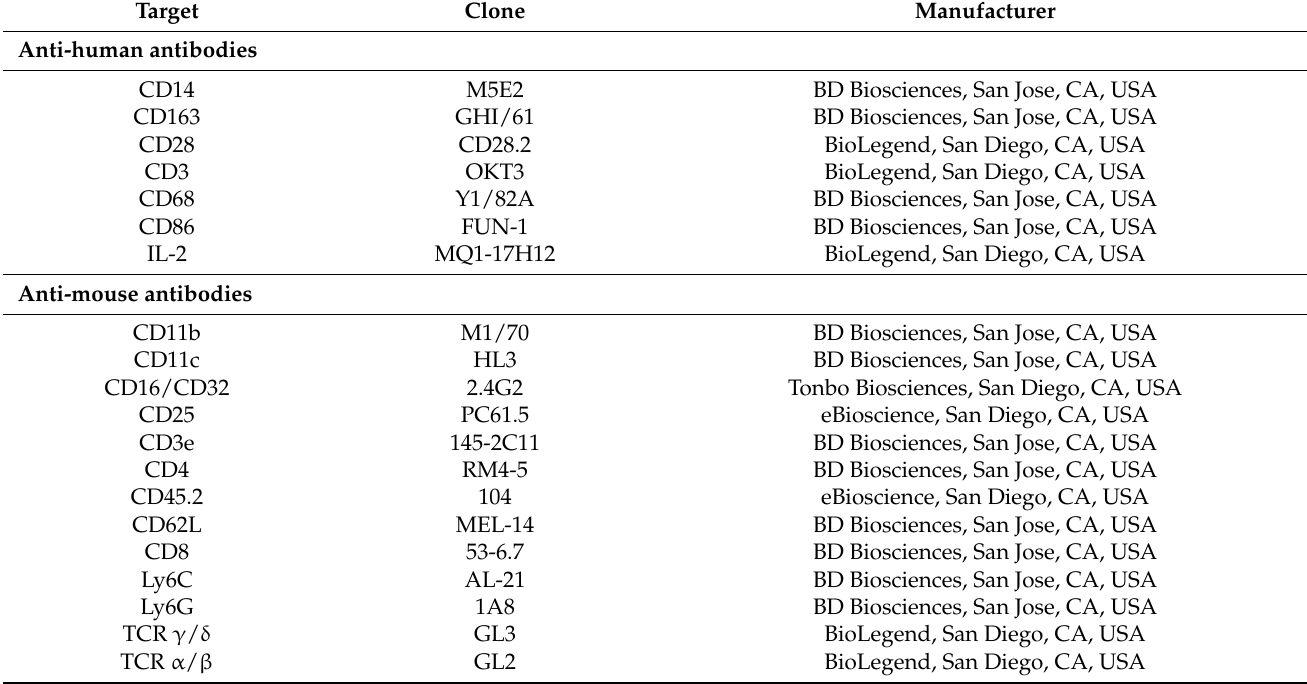
Table 1. Human and mouse antibodies for flow cytometry.